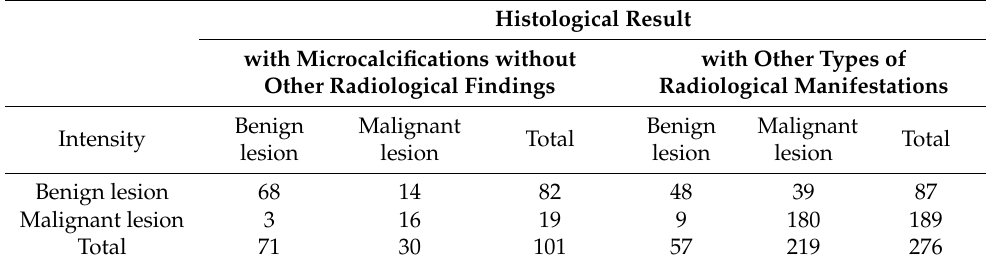
Table 2. Lesion classification according to CESM intensity and histological result (benign vs. any malignant) among lesions with microcalcification without other radiological findings (N = 101) and with other types of radiological manifestations (N = 276). The unenhanced and minimally enhanced patterns (scores 0 and 1) were considered predictive of benignity. The moderate and marked enhanced pattern (scores 2 and 3) were considered predictive of malignancy.